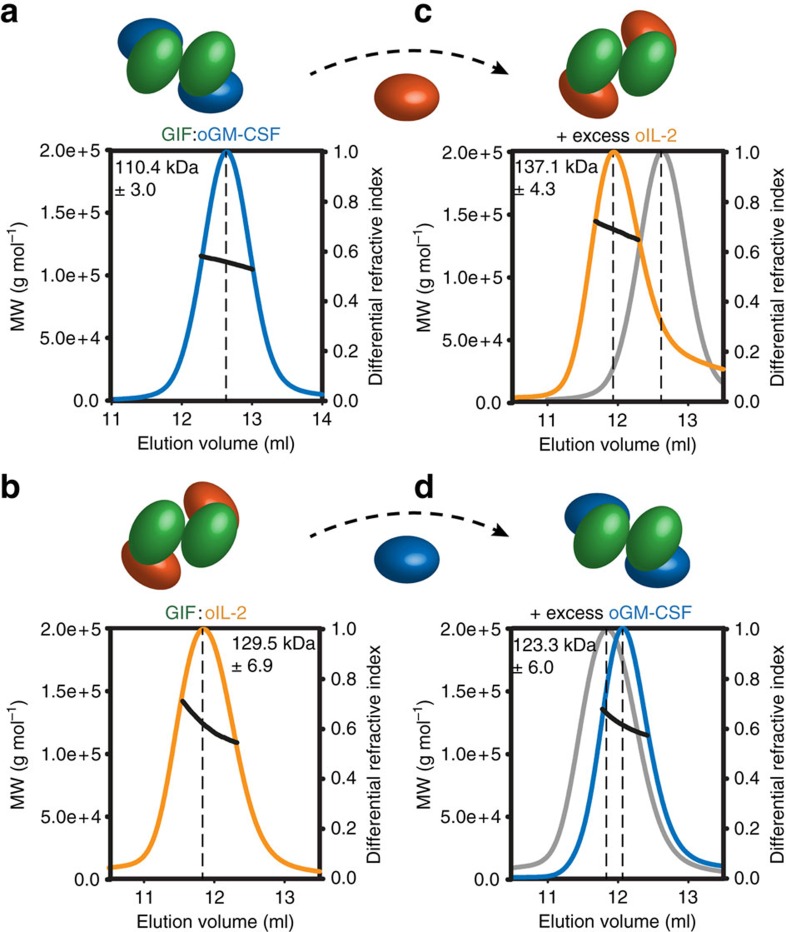
SEC-MALLS analysis of GIF:GM-CSF and GIF:IL-2 complexes.MALLS analysis of GIF:GM-CSF (a) and GIF:IL-2 (b) complexes purified after co-expression of GIF and GM-CSF/IL-2 in HEK293T cells. GIF:GM-CSF (c) and GIF:IL-2 (d) complexes re-purified after addition of a 10-fold excess of purified IL-2 or GM-CSF respectively. For each, a graph is shown plotting the differential refractive index and the derived molecular weight (grey) as a function of the elution volume after SEC. The resulting mean MW and corresponding standard deviation are presented at the top of each chromatogram.